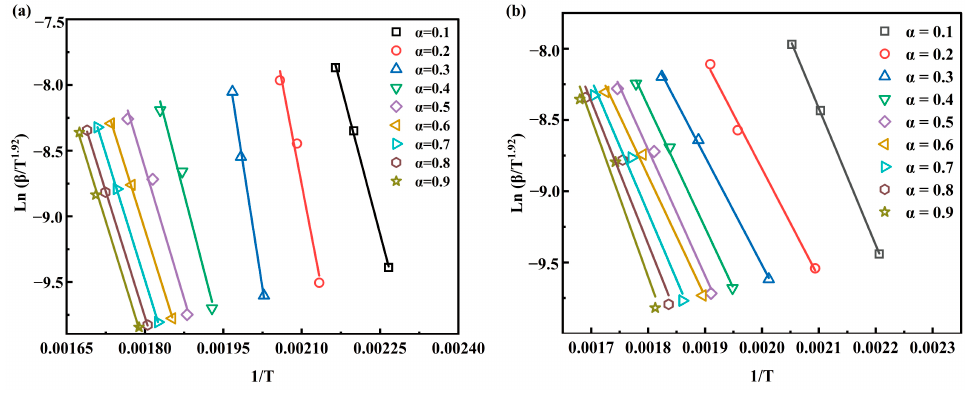
Figure 4. Arrhenius plots of STR: ( a ) no CS, ( b ) with CS. Table 4. Pyrolysis kinetic parameters of WCO-Biodiesel and blends of WCO-Biodiesel with CS at different α .